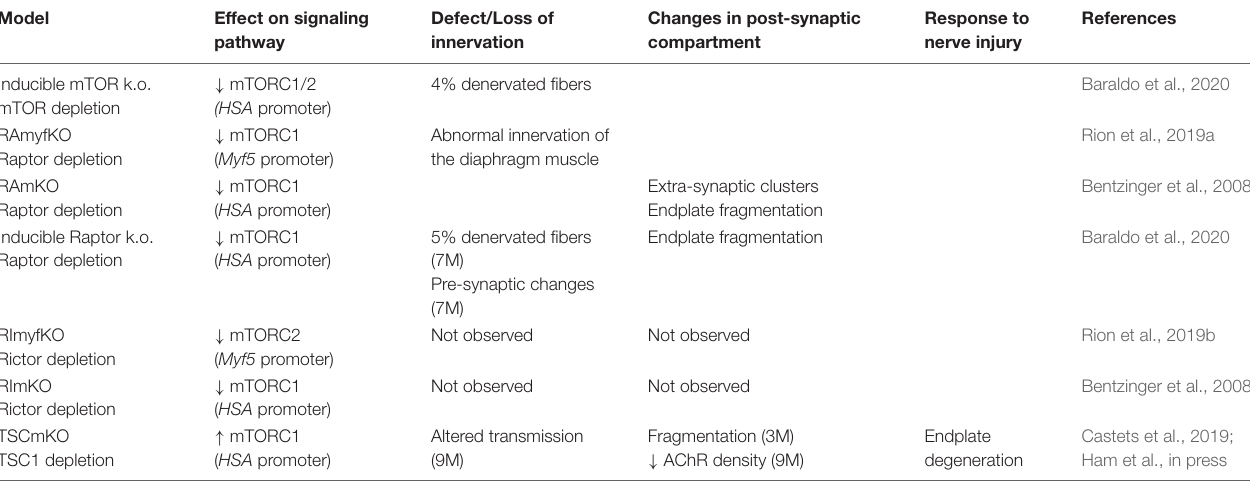
TABLE 2 | Modulation of TOR pathway in mouse and its effects on